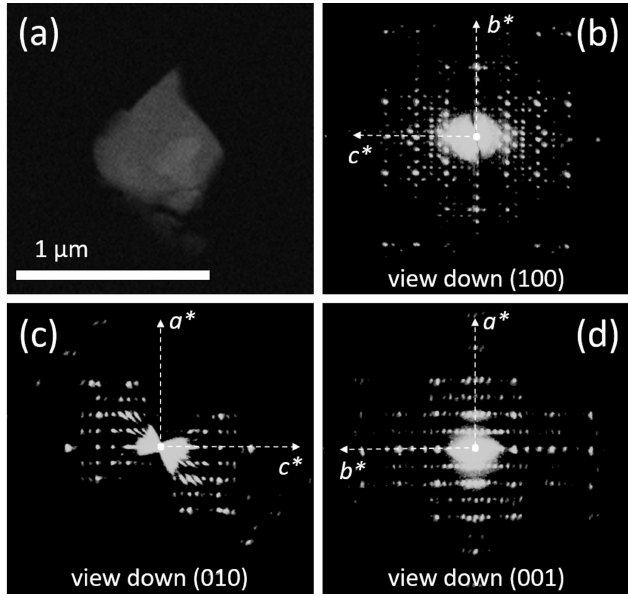
Figure 5 ( a ) HAADF–STEM image of a typical crystal of compound VI, used for 3D ED data acquisition. ( b )/( c )/( d ) Reconstructed 3D ED data viewed along the main crystallographic